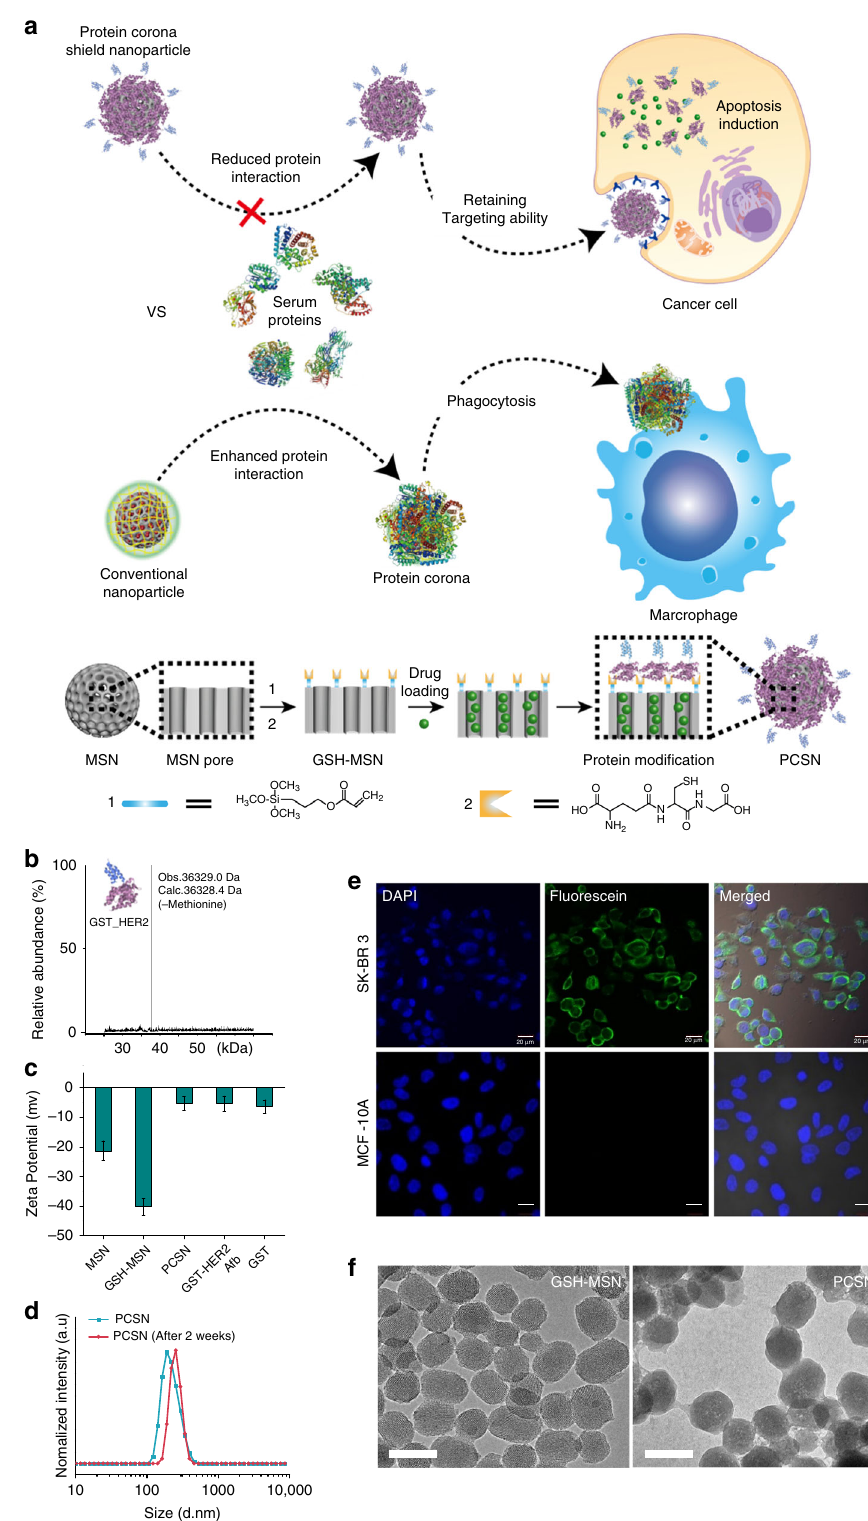
chromatography tandem mass spectrometry (LC-MS/MS)]. A total of 183 proteins were identi fi ed and the 78 most abundant proteins (at levels >0.01% w/w) were selected and divided into three groups based on the correlation in their relative abundances on each particle (Group 1: GSH-MSN > PEG-MSN > PCSN,